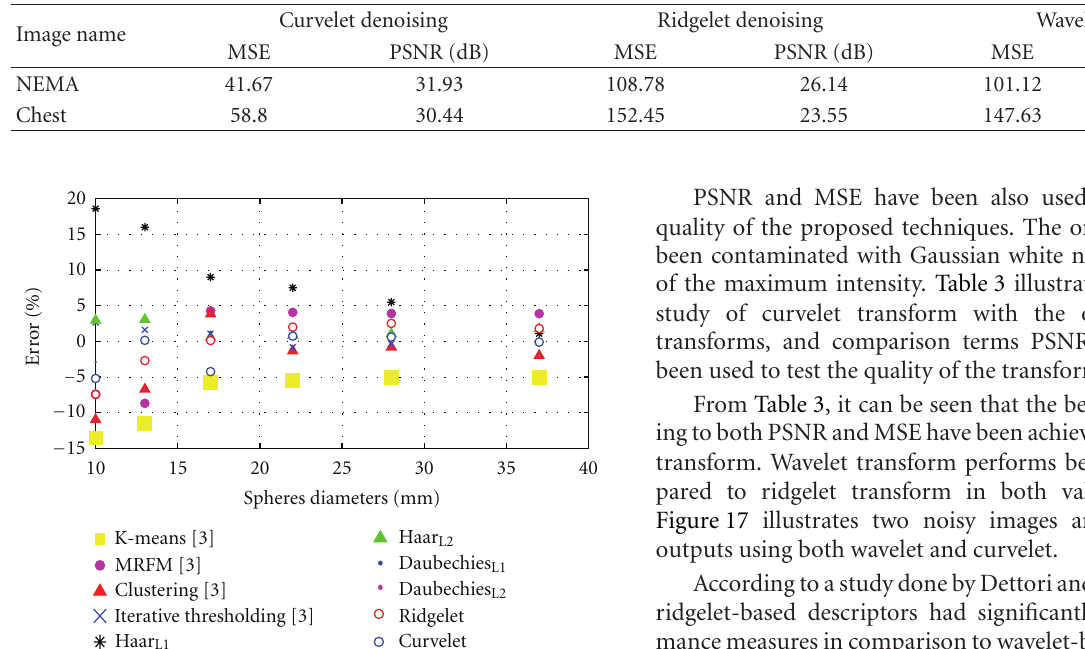
curves are not sharp and ridgelet detect it accurately as it close to be ridges. But for the small spheres, ridgelet weakness for medical image segmentation start appears